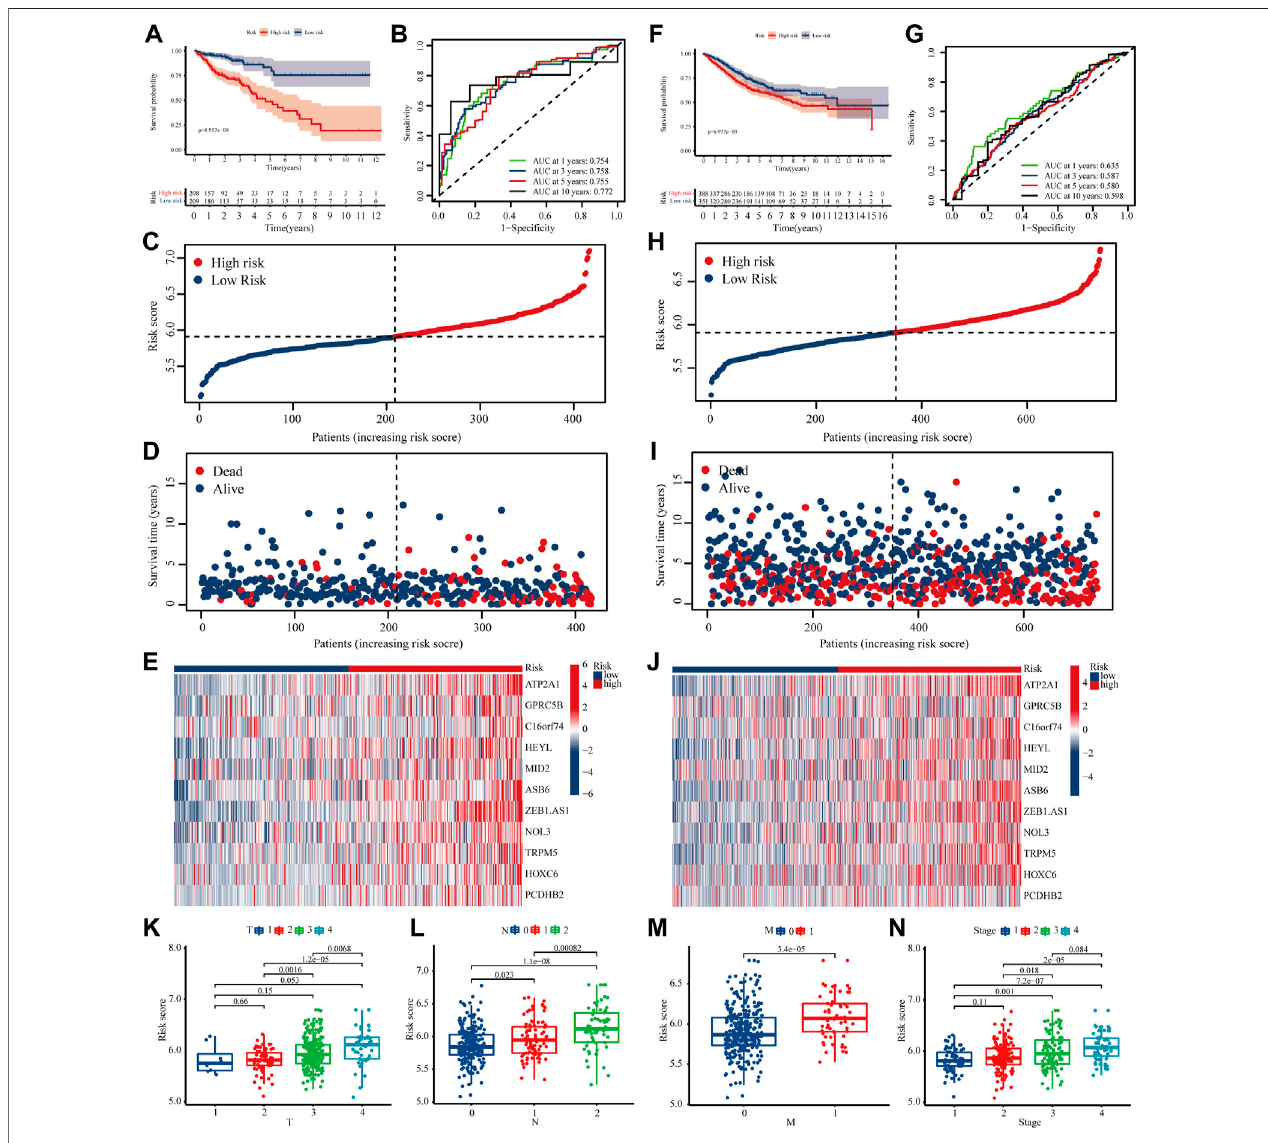
FIGURE4| Validationoftheriskmodelinthetraining set andtestingset (A,F) K-M survivalcurvesforhigh- and low-riskgroups intrainingsetand testing set (B,G) ROC curves for sensitivity and speci fi city of risk models used to predict 1-, 3-,5- and 10- year survival in training set and testing set (C – D, H – I) Scatter plot of m 7 G gene risk scores and patient survival, with red and blue dots representing high- and low-risk patients in training set and testing set (E,J) Expression of gene used to construct risk models in training set and testing set (K – N) Different TNM stage of colon patients in high- and low-risk scores.